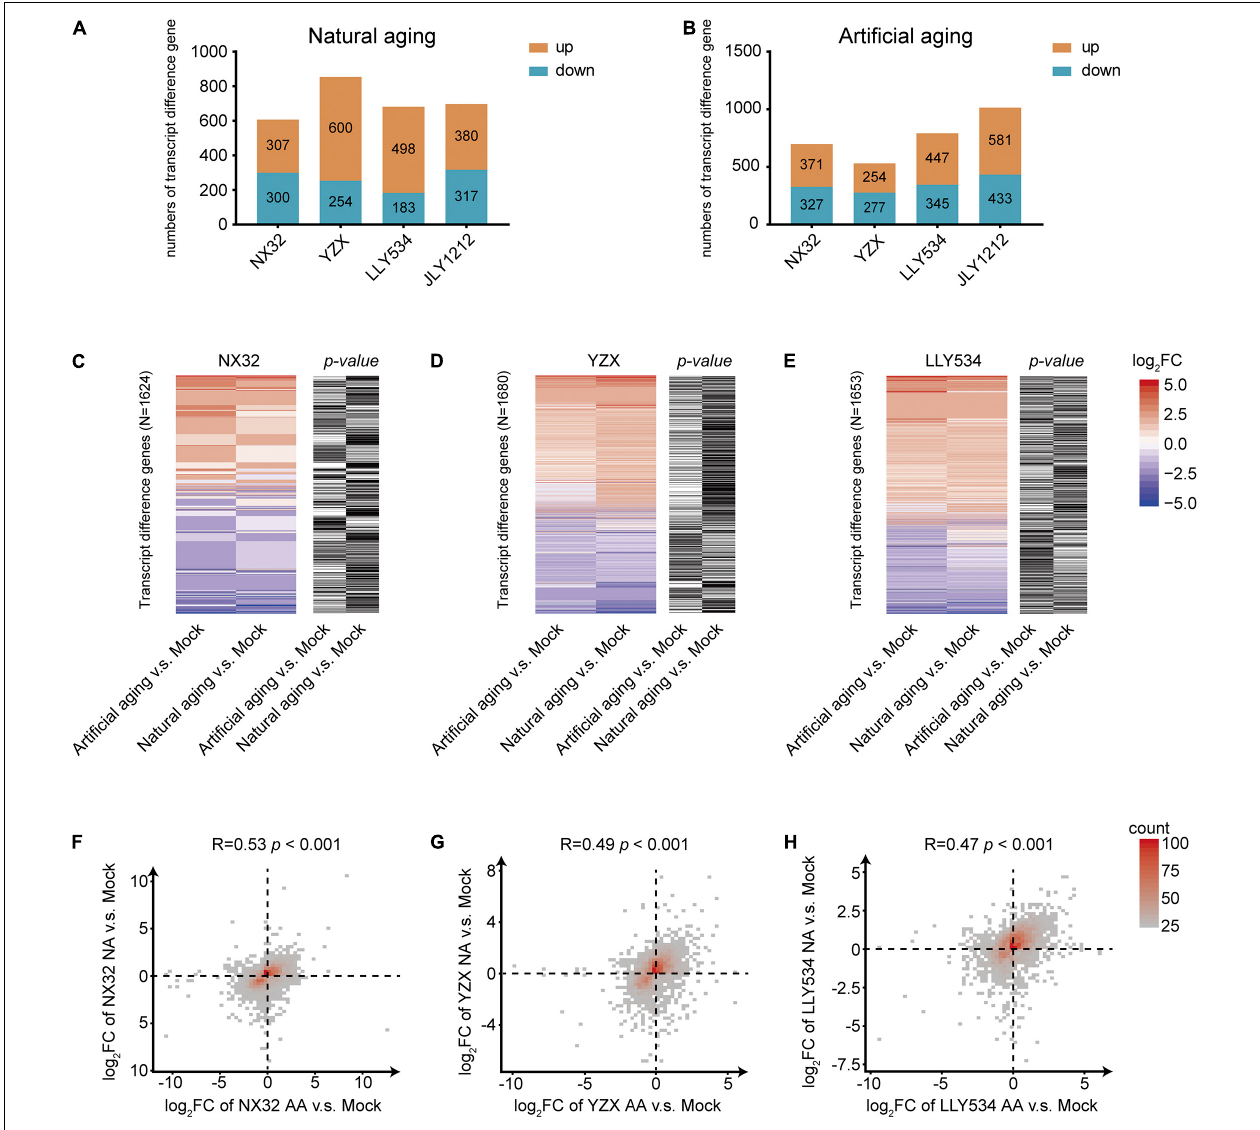
FIGURE 3 | Comparison of gene expression between artificial and natural aging of HL and LL varieties. (A,B) Number of differentially expressed transcripts (| log 2 FC| > 1 and p < 0.05) in the four rice varieties after natural aging (A) and artificial aging (B) compared with mock conditions. (C–E) Heatmap of changes in gene expression in NX32 (C) , YZX (D) and LLY534 (E) after artificial aging and natural aging compared with mock treatment. Blue–red represents mRNA expression levels, where red represents higher mRNA expression levels, and blue represents lower mRNA expression levels. Black–white represents the p- value of the expression